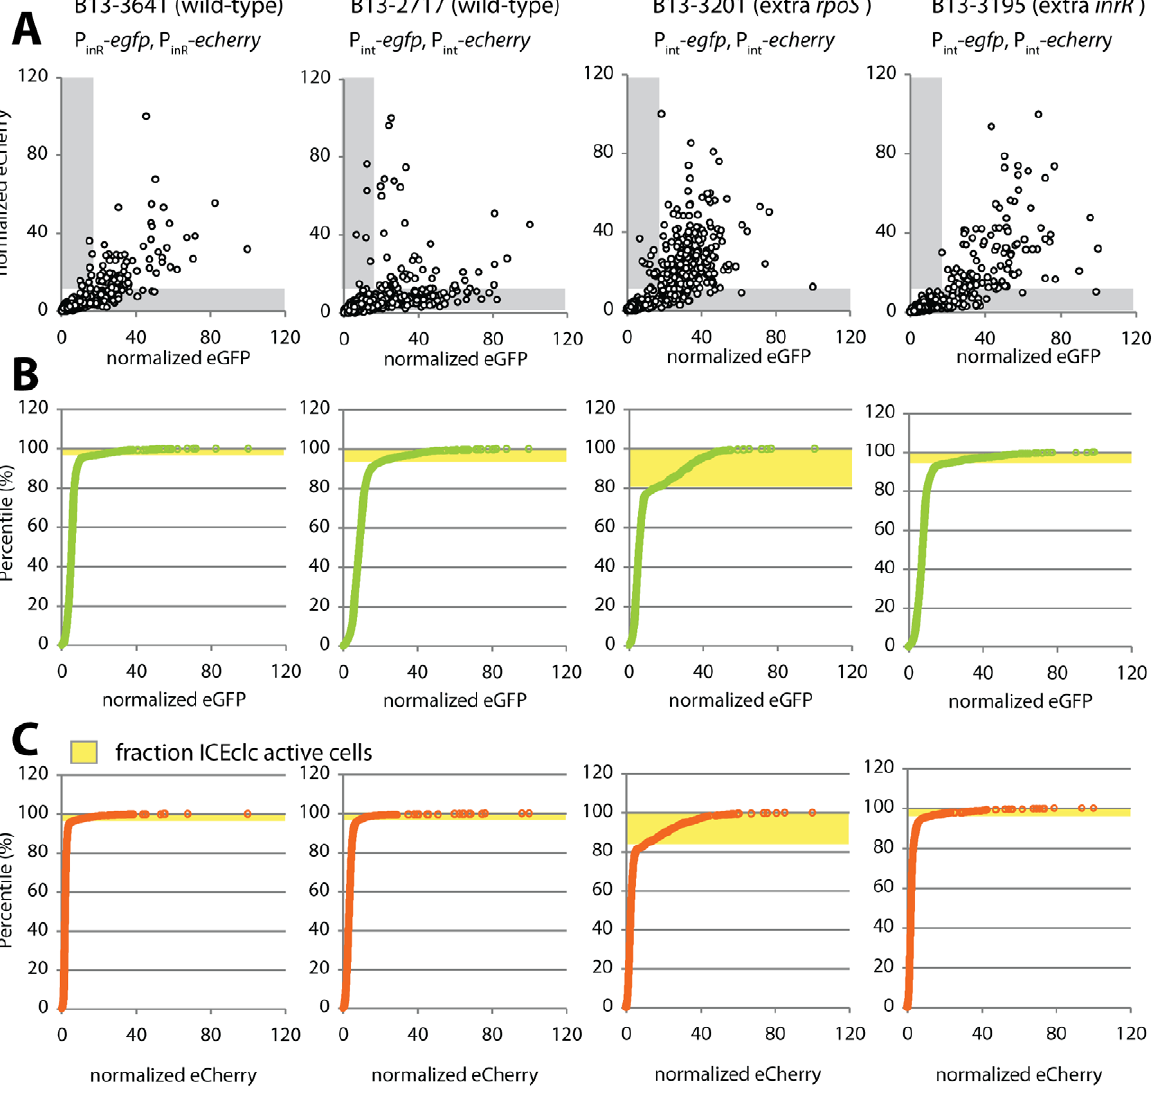
Figure 6. Noise in reporter gene expression from two separately placed single-copy identical promoters (P int or P inR ) in P. knackmussii wild-type (strains 2717 and 3641) or with extra copies of rpoS (B13-3201) or inrR (B13-3195). (A) Scatter plots showing correlation between single cell scaled and normalized eCherry versus eGFP fluorescence values (circles) in stationary phase 3CBA-grown cultures. Grey zones indicate cells which express only one of both markers above threshold (for explanation, see Figure S8). (B) Cumulative distribution of single cell eGFP fluorescence values in the culture sample, used to define the subpopulation size of cells expressing eGFP from the P int or P inR promoters above threshold (in yellow). (C) as B, for the eCherry